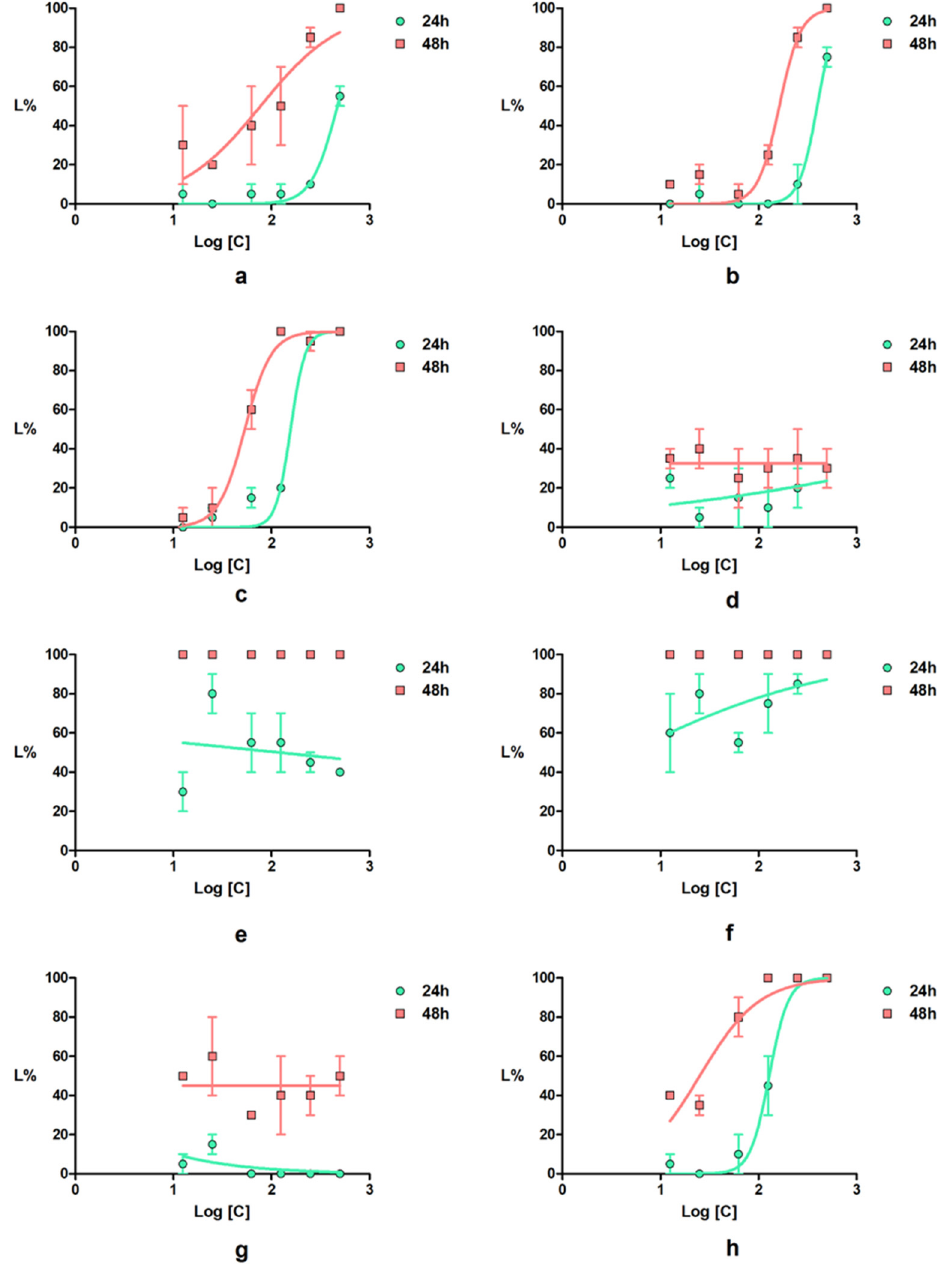
Figure 8. Daphnia magna lethality curves for the tested compounds: ( a ) 2a ; ( b ) 2b ; ( c ) 2c ; ( d ) 4a ; ( e ) 4b ; ( f ) 4c ; ( g ) 4d ; ( h ) indomethacin; error bars represent the standard error of the mean.